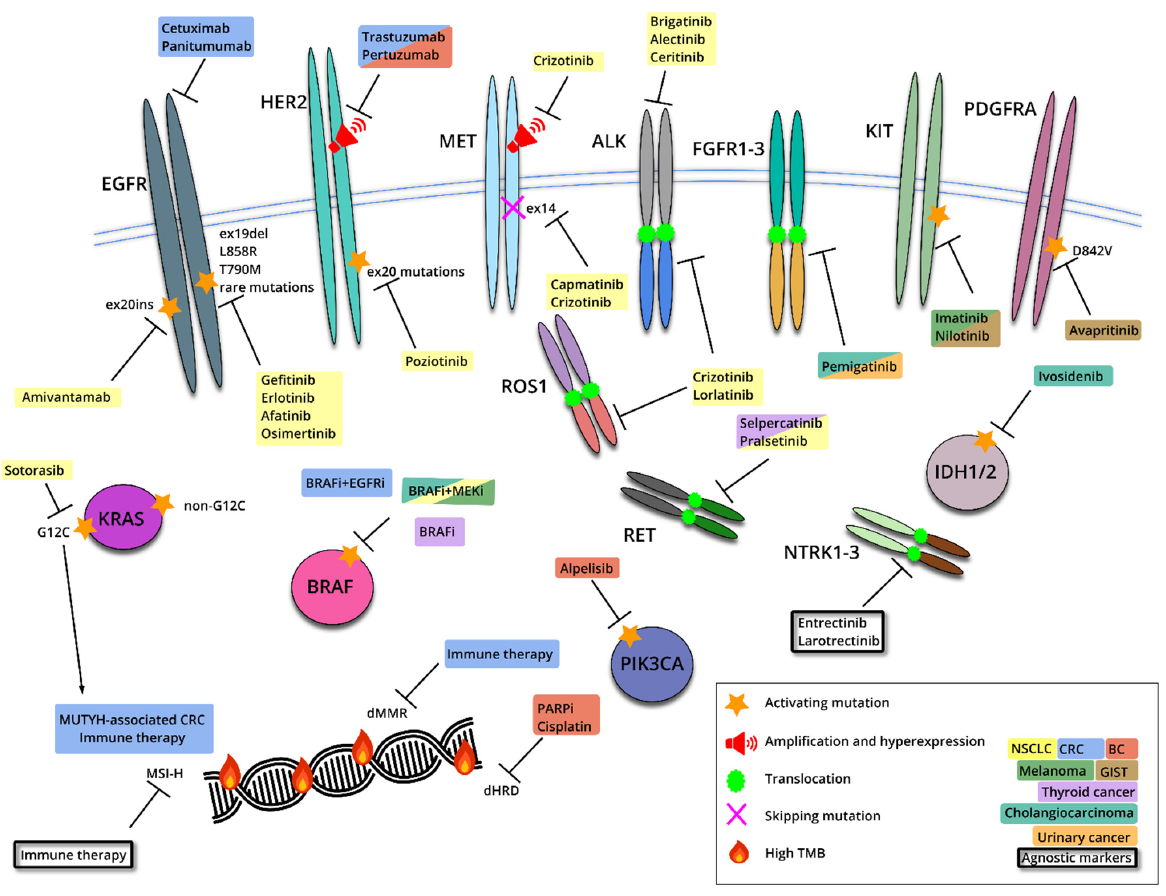
Figure 3. Examples of tissue-specific and agnostic drug targets. Most known druggable mutations occur in tyrosine kinase membrane receptors, however, some of these molecules can relocate to other cellular compartments due to mutational events. Some targets and drugs are generally relevant only to a single tumor category (e.g., EGFR mutations in NSCLC), other indications include several cancer types (e.g., use of BRAF inhibitors for BRAF V600E mutated tumors), and a few targeted therapies are considered agnostic. The T-shaped lines illustrate the blockade of particular targets by various drugs.